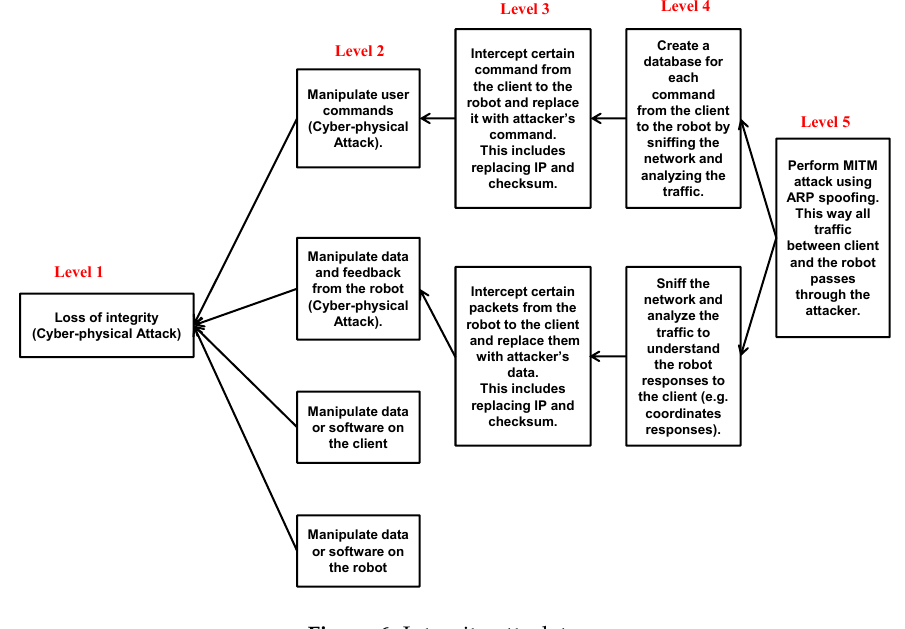
Figure 6. Integrity attack